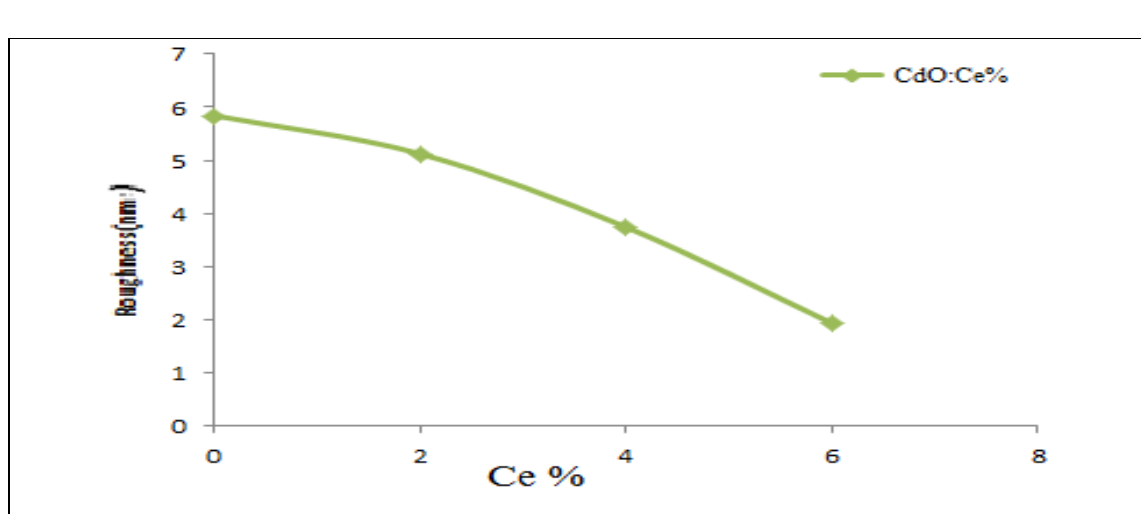
Fig. 10: Variation of roughness with Ce concentration for CdO prepared silicon